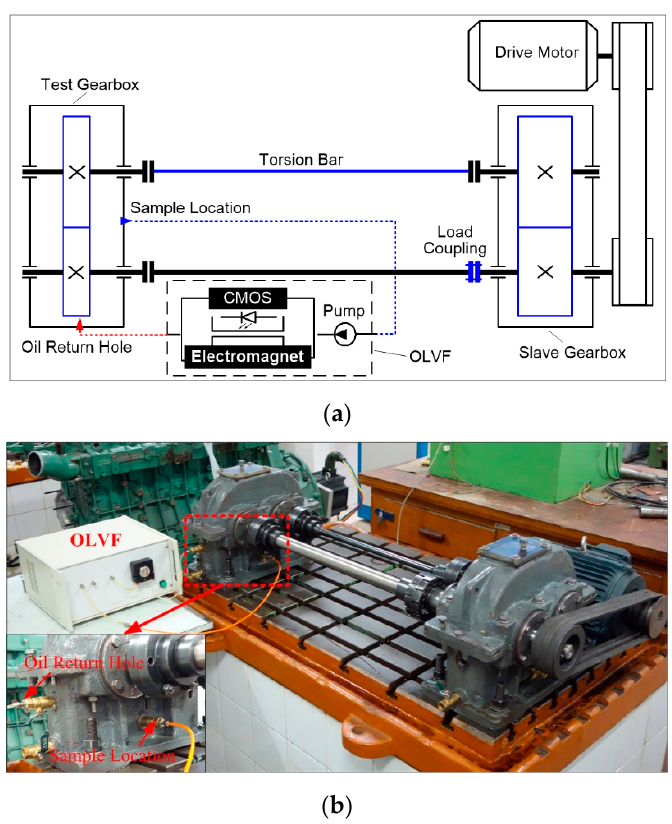
Figure 9. Back-to-back gear test rig: ( a ) schematic; ( b ) photograph.